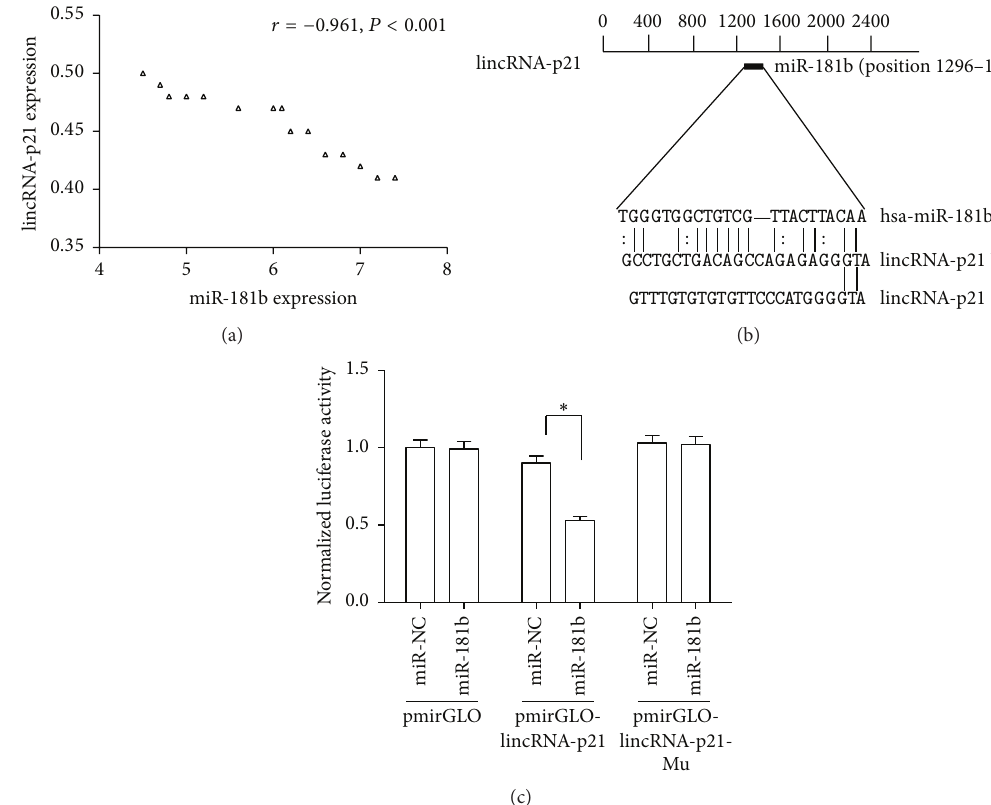
Figure 4: The effect of lincRNA-p21 on PTEN expression is through competitively binding miR-181b. (a) Correlation between lincRNA-p21 level and miR-181b expression in liver tissue samples from cirrhotic patients ( 𝑛 = 15 ) was subjected to Pearson correlation analysis. (b) Schematic diagram of the miR-181b binding site in the lincRNA-p21 based on RNA22 software. (c) Relative luciferase activities of luciferase reportersbearingwild-typeormutantlincRNA-p21 wereanalyzed 48hfollowing transfectionwith theindicated miR-181bmimicsormiR-NC in LX-2 cells. Each value is the mean ± SD of three experiments. ∗ 𝑃 < 0.05